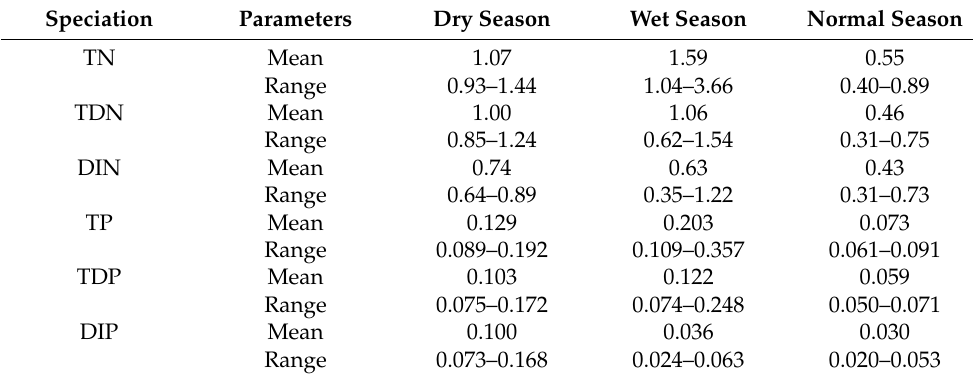
Table 1. Seasonal mean and range of TN, TDN, DIN, TP, TDP and DIP concentrations in the MWS (mg/L).